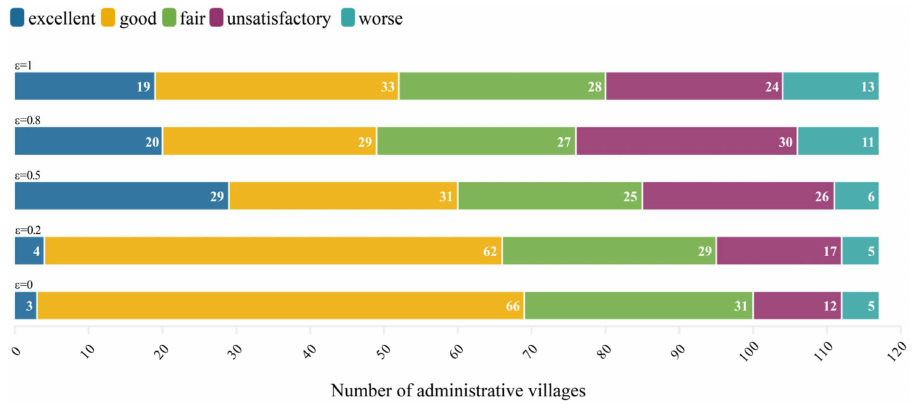
Figure 2. Classification of villages by IERSE in